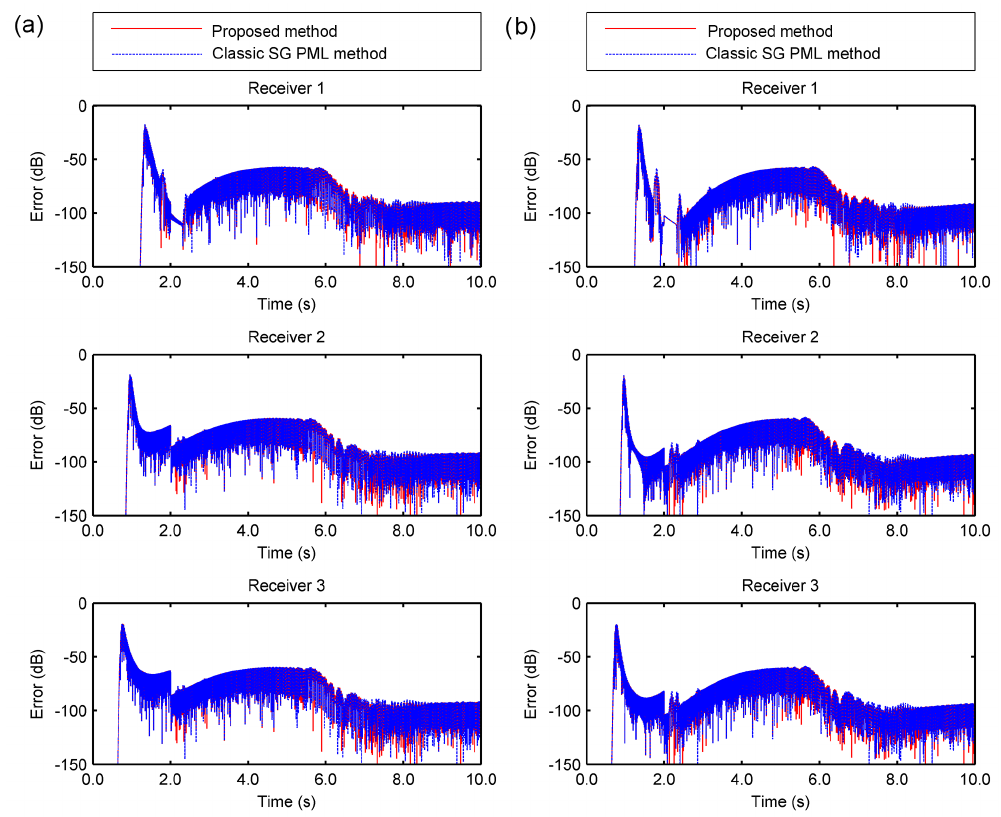
Figure 5. Comparison of the relative errors between the analytical solutions and the proposed method (second-order CG scheme) (red solid line) or the classic SG PML method (second-order SG scheme) (blue dotted line) at different receivers and different grid spacings. (a) d = 12m, receivers 1, 2, and 3; (b) d = 10m, receivers 1, 2, and